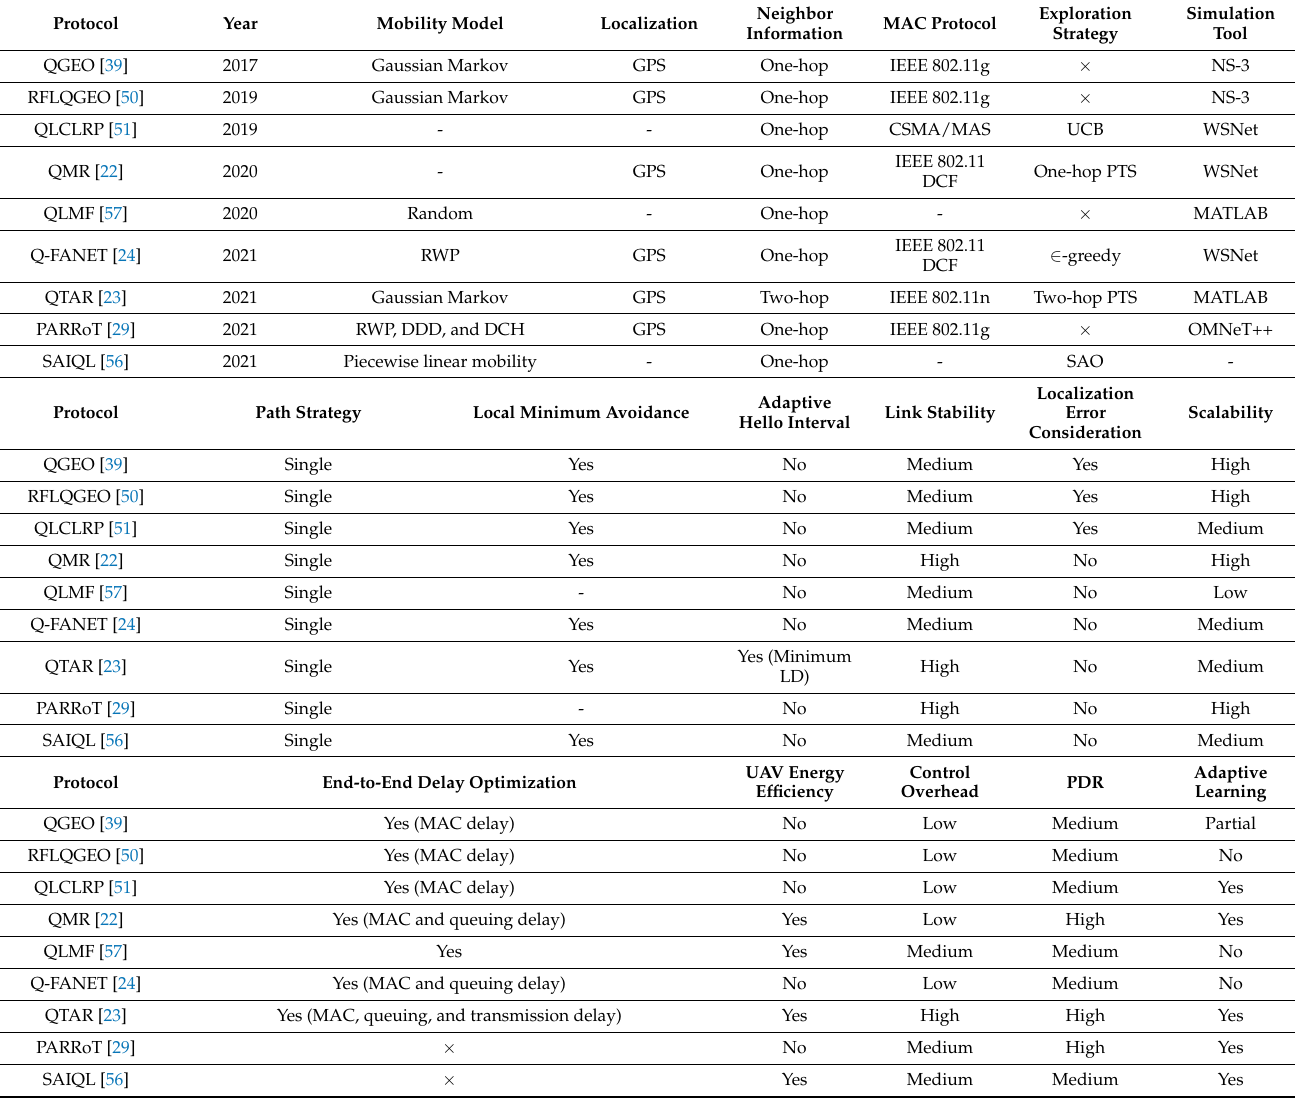
Table 7. Qualitative comparison of QL-based position-aware routing